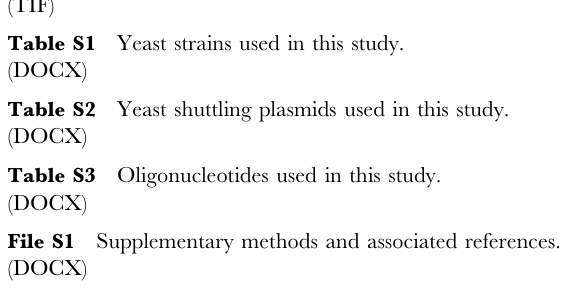
Figure S2 Western blot analysis of protein levels for full-length and point mutant derivatives of ScPat1. Lsm1 was used as a loading control. Table S1 Yeast strains used in this study. Table S2 Yeast shuttling plasmids used in this study. Table S3 Oligonucleotides used in this